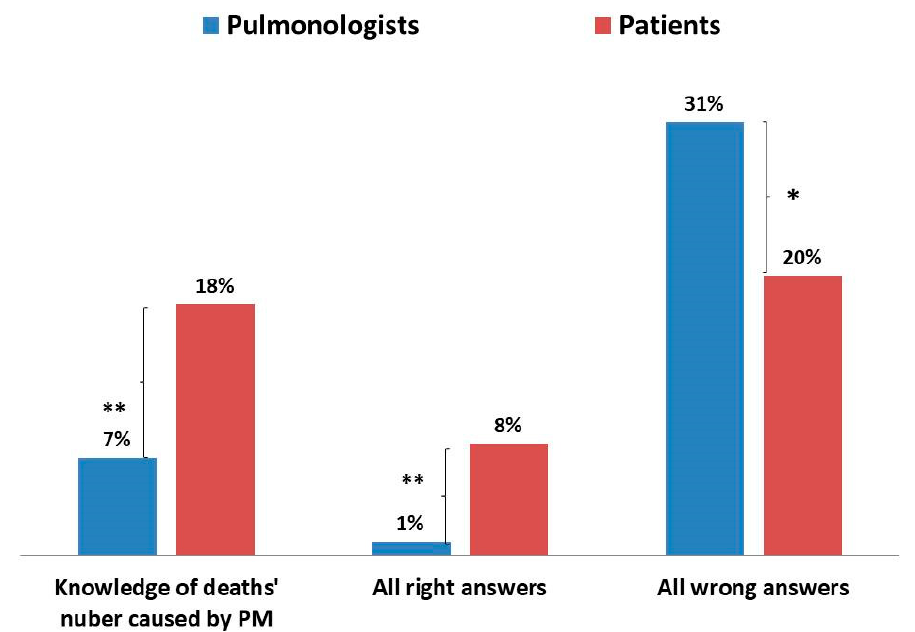
Figure 9. Patients’ and pulmonologists’ global knowledge about the impact of air pollution (*, ** p < 0.001) .